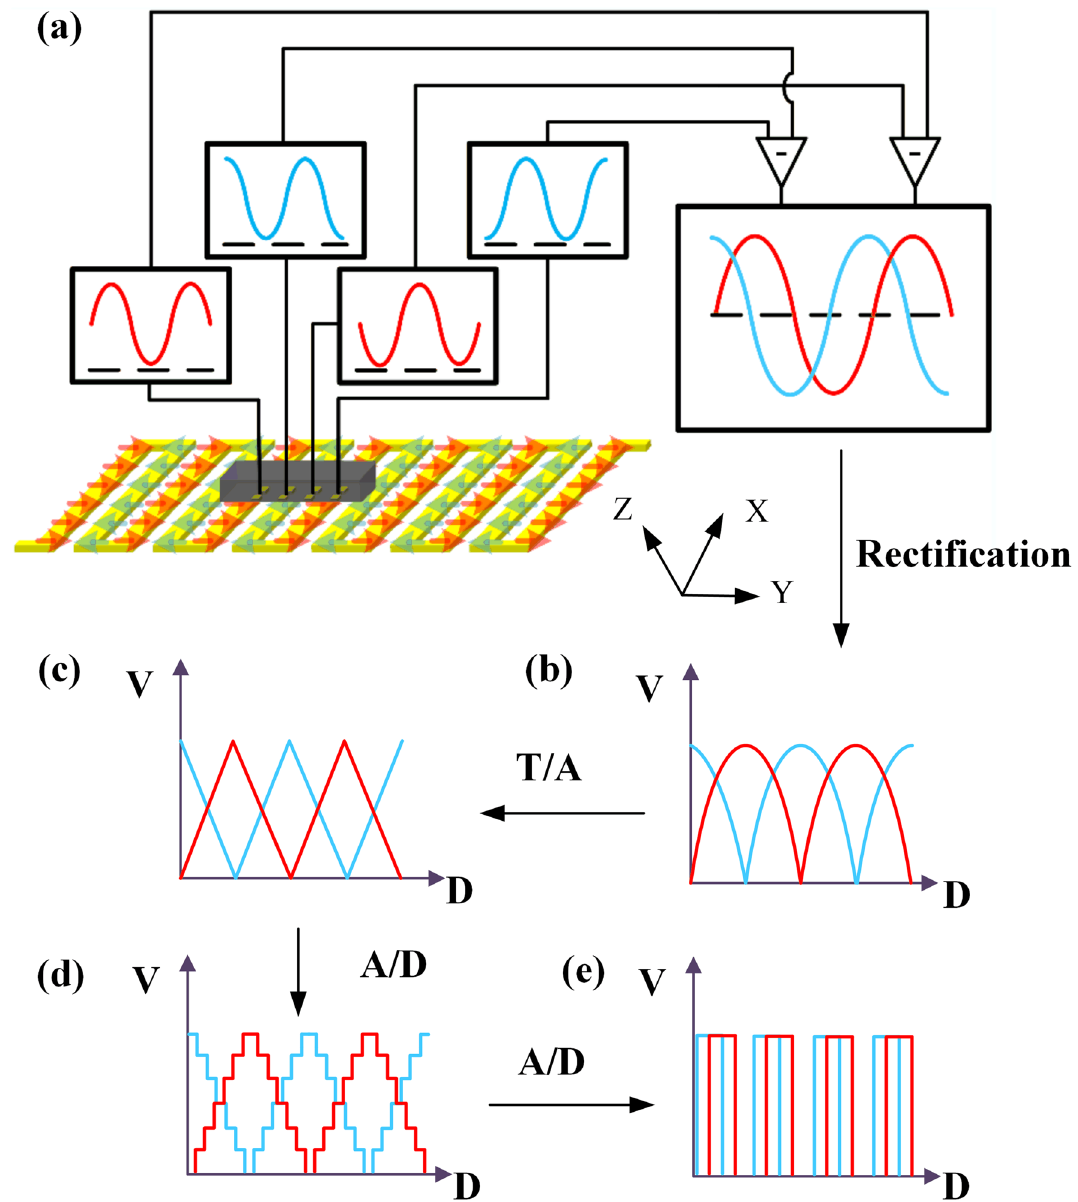
Figure 8. Principle of subdivision interpolation circuit. ( a ) A couple of sinusoids with phase difference of 90 ◦ (Created by Microsoft Visio 2013 (15.0) and SOLIDWORKS(R) Premium 2016.). ( b – d ) Process of the interpolation circuits converting the two sinusoidal signals into an industry standard incremental quadrature digital